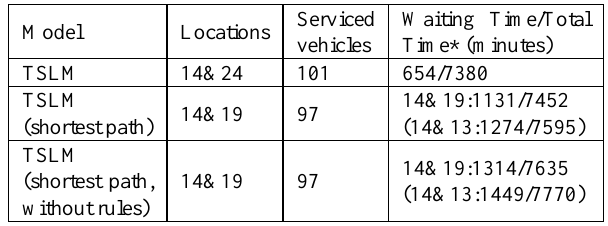
Table 1.Results of Different